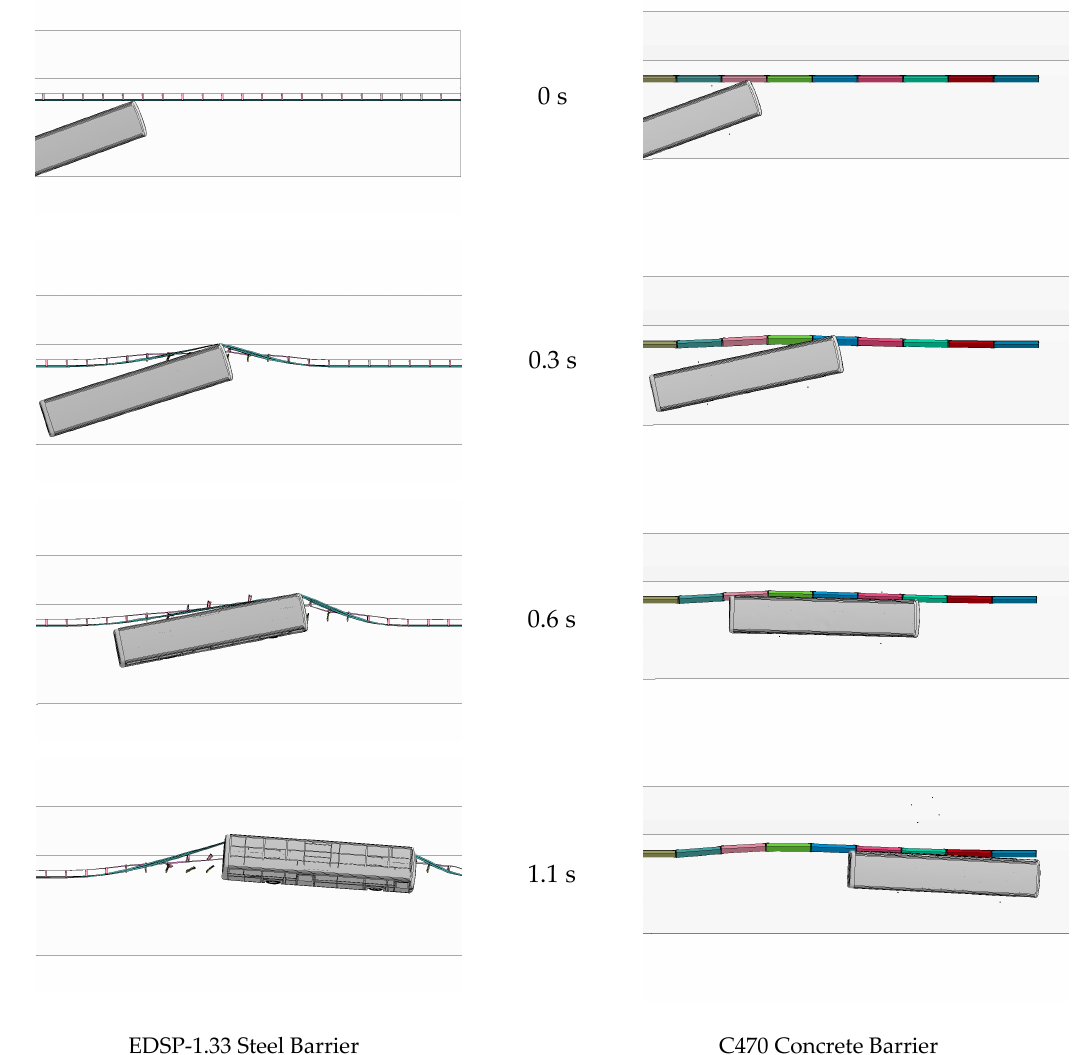
Figure 11. Sequential overhead picture comparison of steel EDSP-1.33 and concrete C470 barriers after the bus impact simulation.